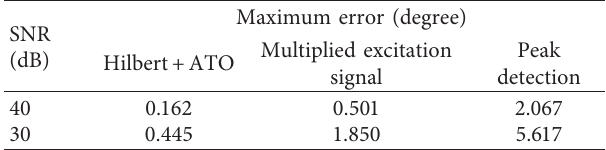
Table 2: Decoding errors of various decoding methods for noise- containing